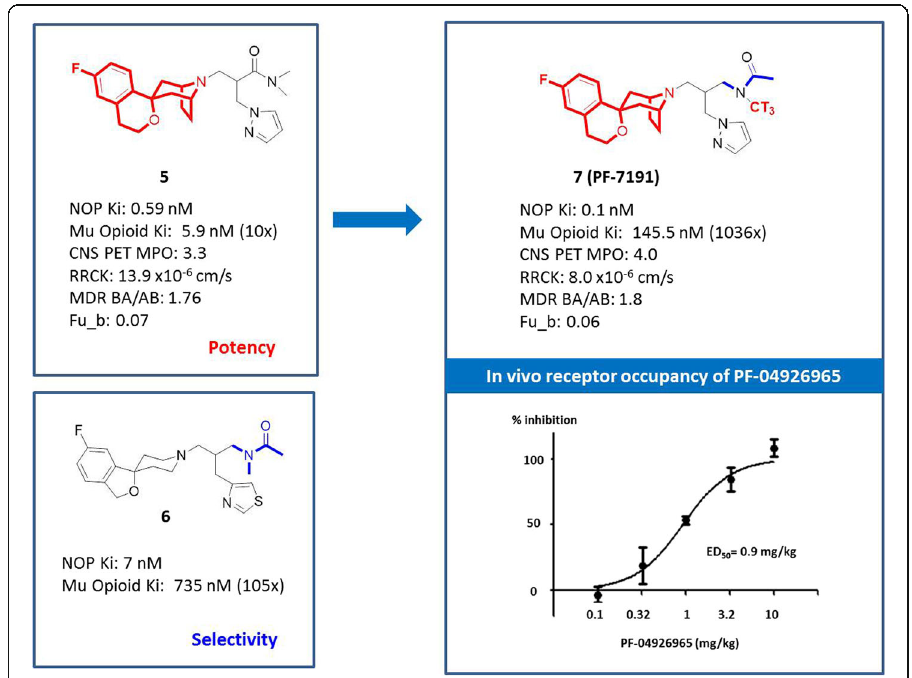
Fig. 5 Discovery of a NOP-selective in vivo radiotracer [ 3 H]PF-7191 guided by CNS PET ligand design parameters